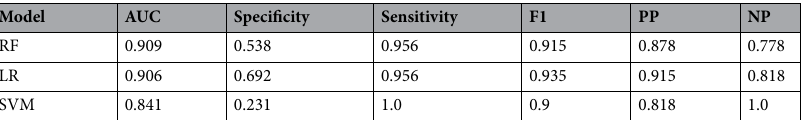
Table 2. Parameters of ccRCC and non-ccRCC in the testing set. ccRCC clear cell renal carcinoma, AUC area under the curve, PP positive prediction, NP negative prediction, RF random forest model, LR logistic